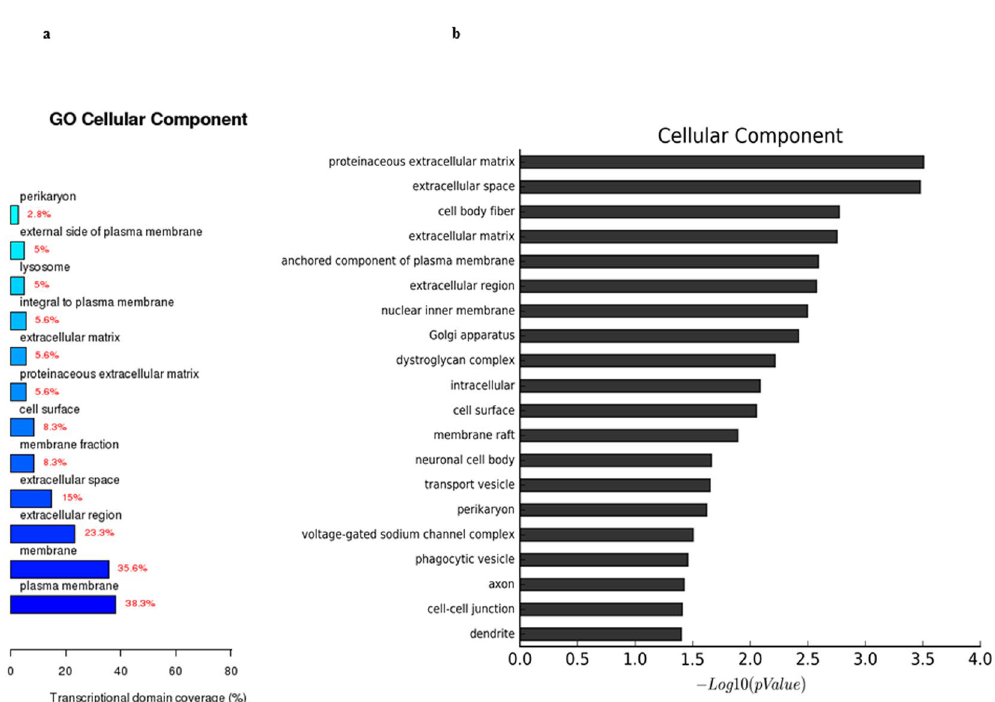
Figure 9. The RCCS-3D vs static-3D group comparison that gene ontology analysis of differentially expressed genes in cellular component. ( a ) Top 20 terms based on most significant p value of biological processes. ( b ) Top 12 terms based on the differential genes were most extensive transcriptional domain